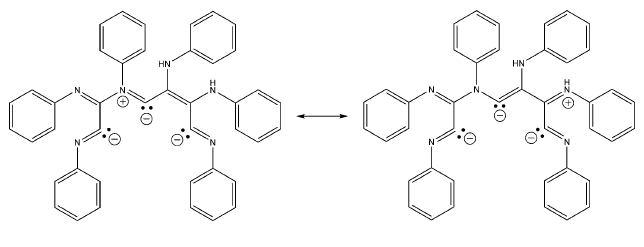
Figure 3 Two proposed resonance forms of the tridentate dianion of 2 based on the bond lengths.